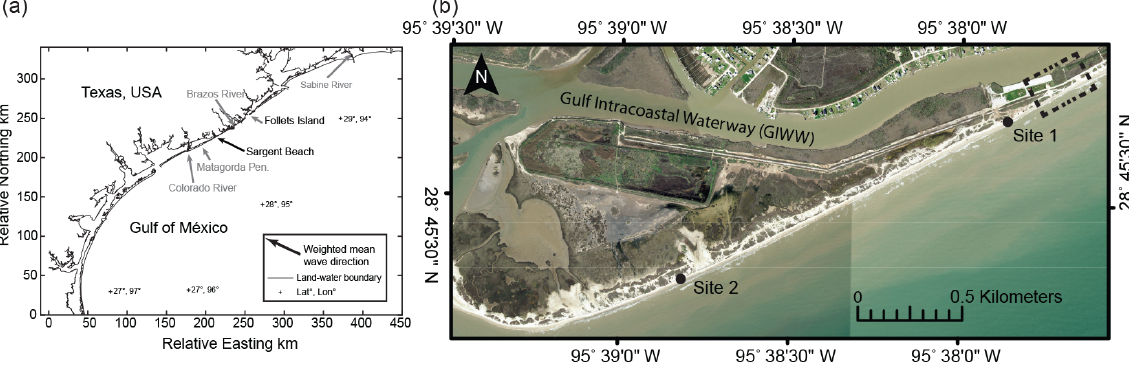
Figure 1. (a) Regional map of the Texas coast showing the location of Sargent Beach. (b) Aerial image of two survey sites at Sargent Beach, Texas. Dashed boxes denote the locations of Sites 1 and 2. Site 1: sea cliff. Site 2: shore platform. The dashed line represents the area where there is the least amount of land between the open ocean and the GIWW. Image source: NOAA. Hurricane Harvey: Emergency Response Imagery of the Surrounding Regions, 2017.